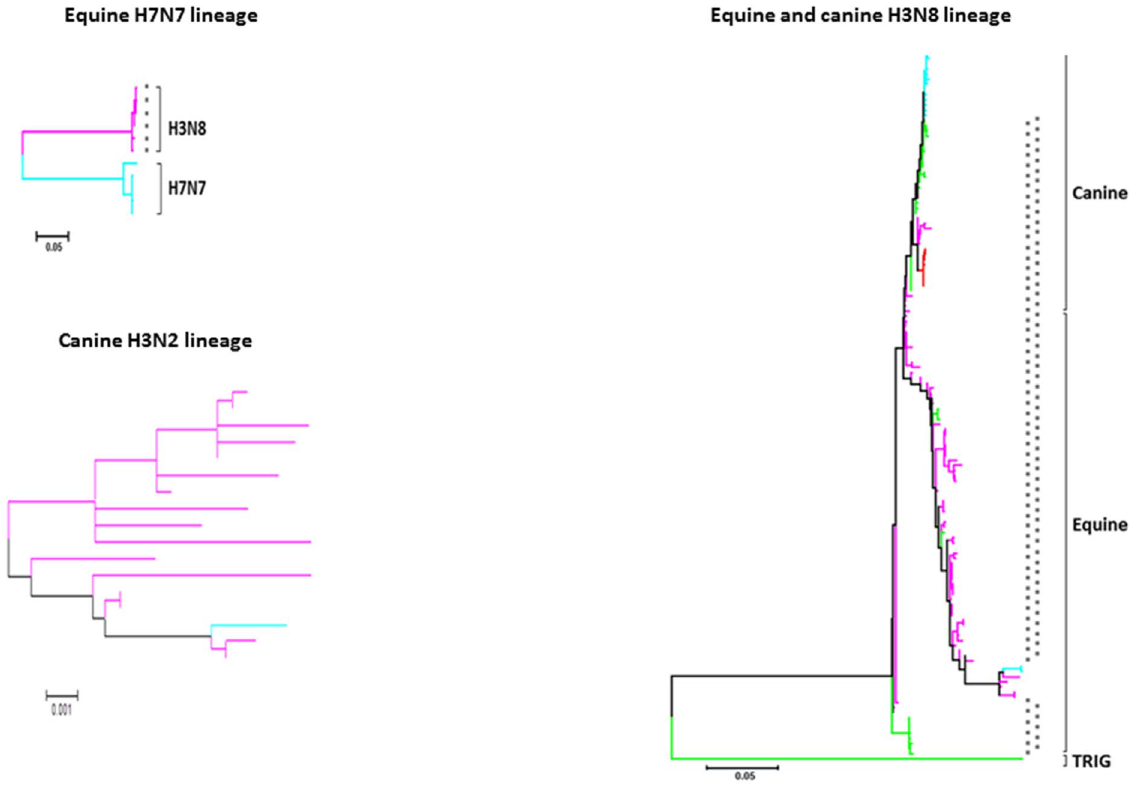
Figure 3. Phylogeny overview of equine and canine influenza A PB1 genes. Maximum likelihood phylogenetic trees for 96 equine and 63 canine H3N8, 11 equine H7N7, and 19 canine H3N2 viruses were generated. 1, 2, 3, and 4 inflammatory residues are indicated in blue, green, fuchsia, and red, respectively. The presence of one or two cytotoxic residues is indicated by one or two asterisks, respectively. Cyan indicates PB1-F2 protein truncated before residue 62. More detail, including strain names and bootstrap values, is shown in Figure